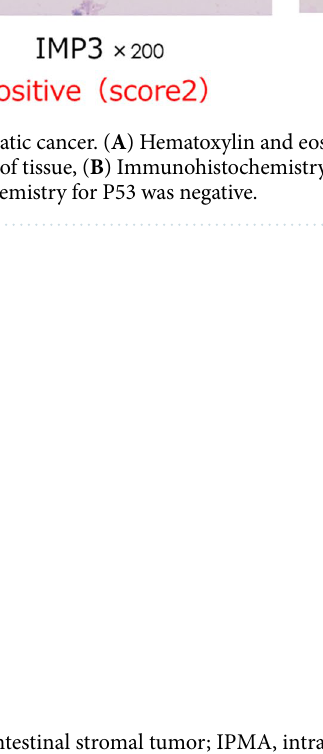
Table 2. Final diagnosis. GIST, gastrointestinal stromal tumor; IPMA, intraductal papillary-mucinous adenoma; IPMC, intraductal papillary-mucinous carcinoma; MANEC, mixed adenoneuroendocrine carcinoma; PNET, pancreatic neuroendocrine tumor; SPN, solid-pseudopapillary